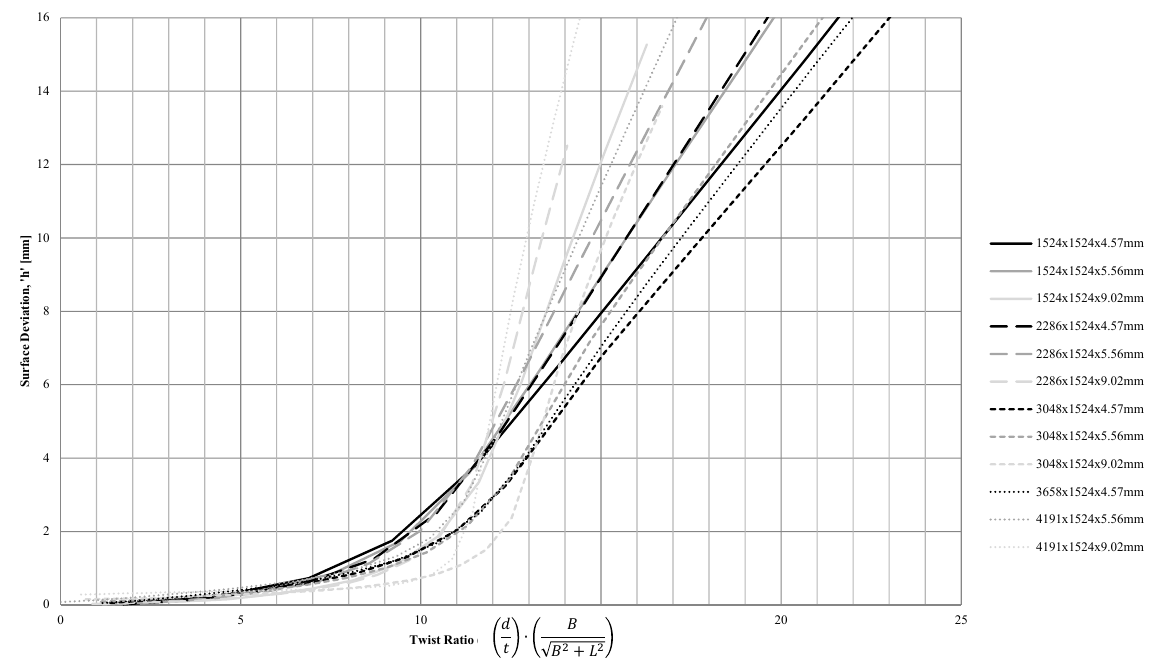
Fig. 7 Finite Element Model Buckling Surface Deviation at Increasing Twist Based on Ratio, k